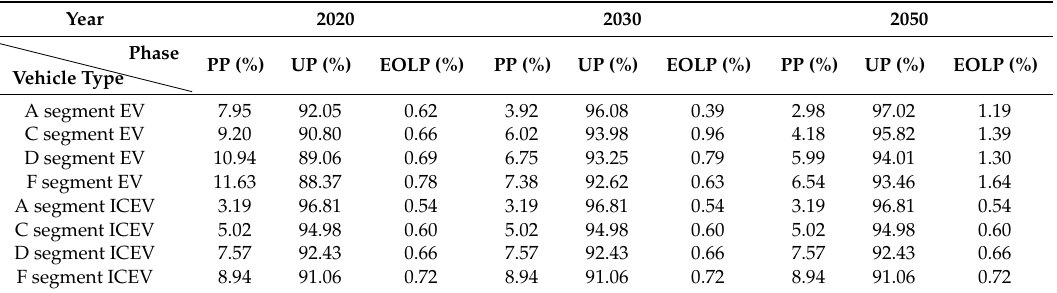
Table 3. Values of share for production phase, use phase and end of life phase of different vehicles.